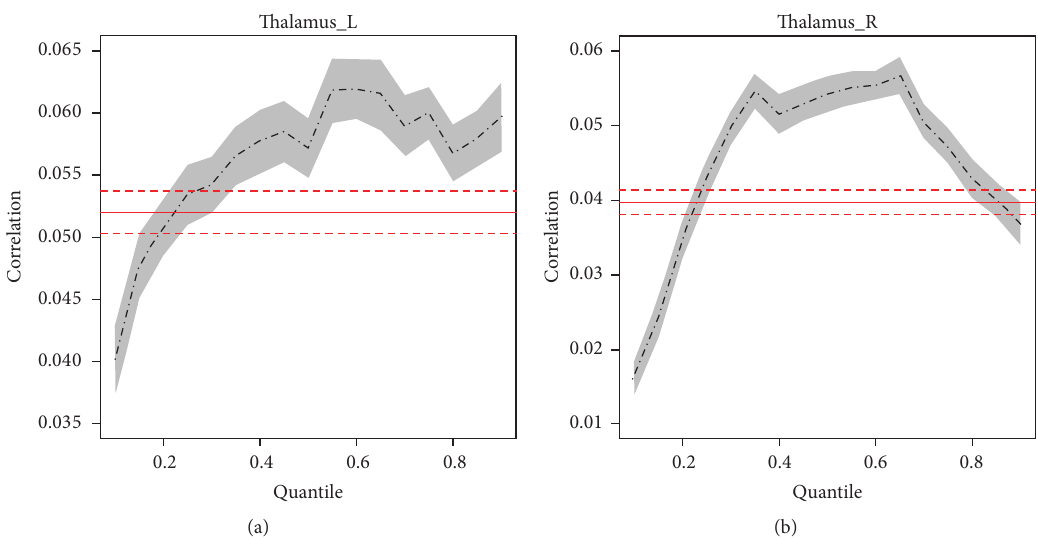
Figure 6: Results of quantile analysis from comparisons of coefficients of cross-correlation (FC) between minimal (first 100s) and significant (last 100 s) fatigue stages in bilateral thalamus. Comparisons were made at each quantile of the distribution curve between minimal and significant fatigue conditions in bilateral thalamus. ANOVA results were plotted in red (solid line = mean; dotted line = 95% confidential